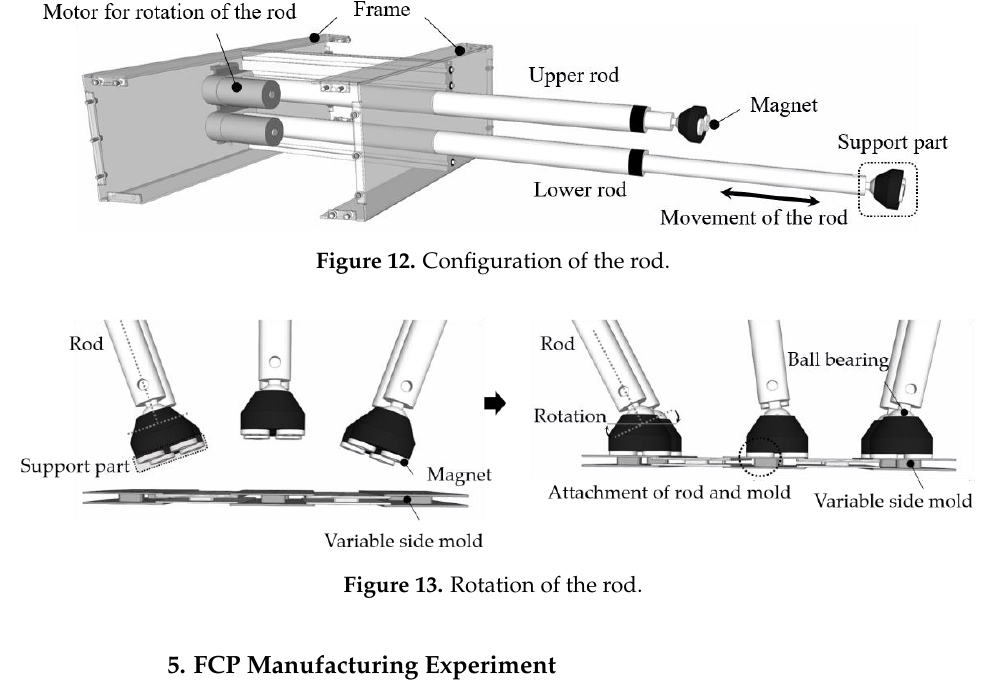
Figure 11. Side mold control equipment.